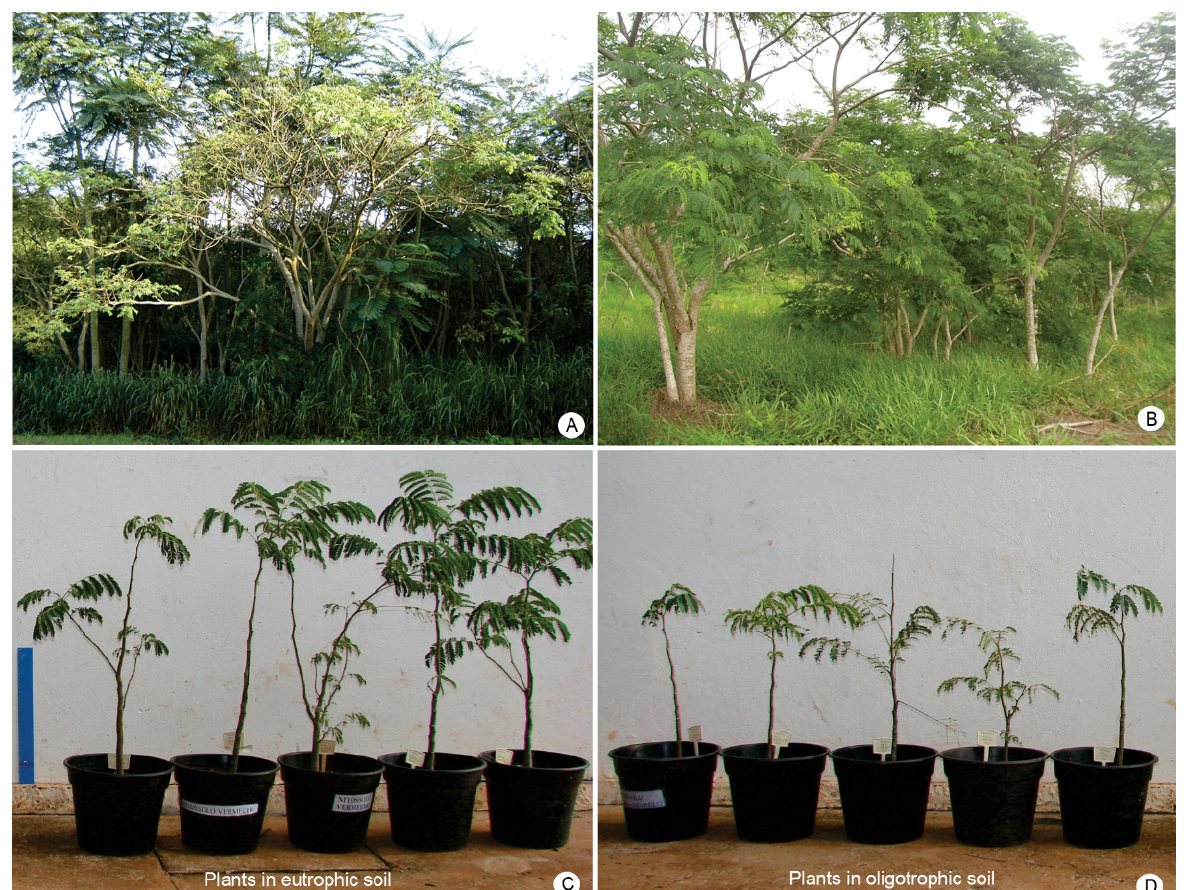
Figure 1. Studied 9-year-old trees ( A , B ) and 2-year-old saplings ( C , D ) of Enterolobium contortisiliquum . ( A – C ) Plants in eutrophic soil. ( B – D ) Plants in oligotrophic soil. Note the saplings are taller in eutrophic soil ( C ) than in oligotrophic soil ( D ). Blue vertical bar = 35 cm in C.